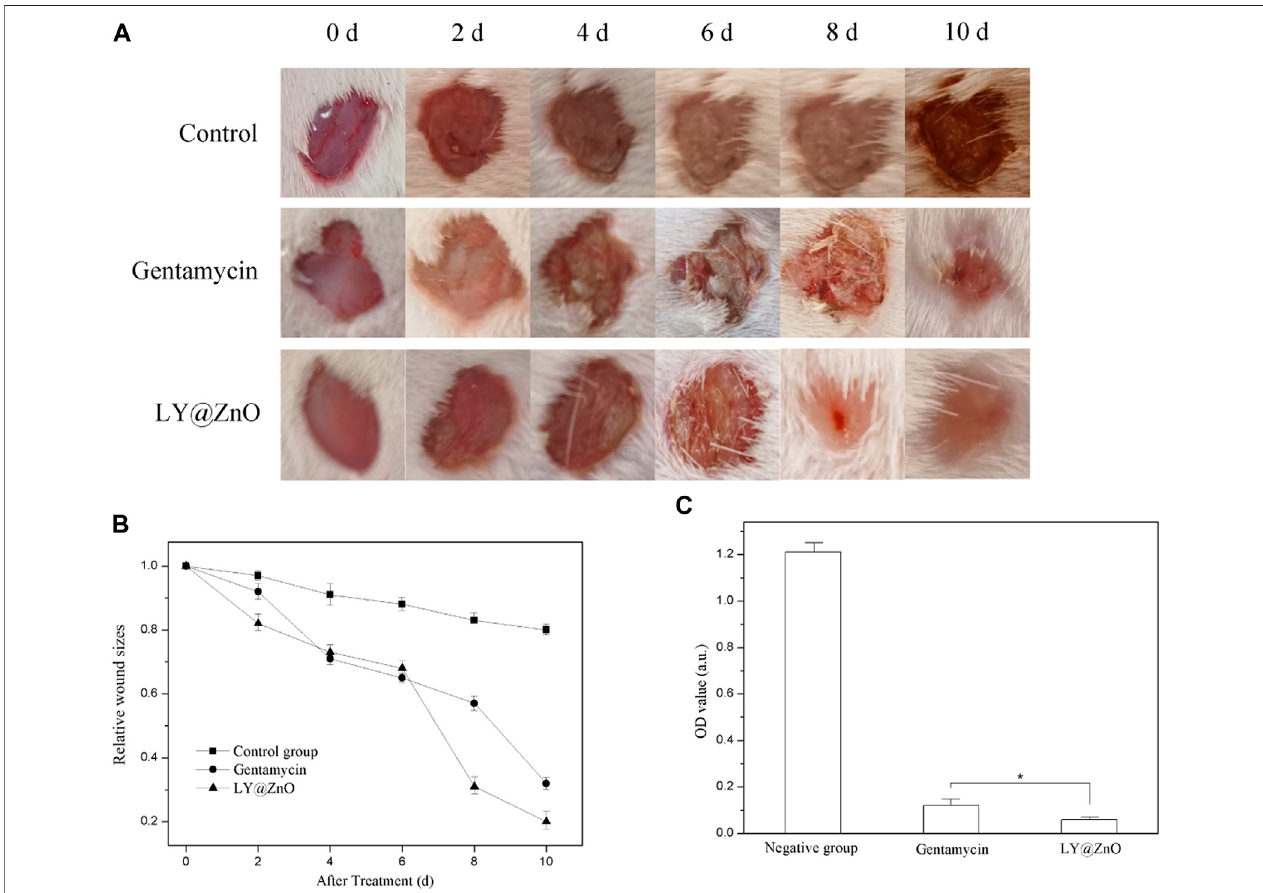
FIGURE 16 | (A) Images of wounds with sanitary saline, gentamycin, and LY@ZnO injected at different time points, (B) the size of wounds at different time points, (C) the OD value of bacteria obtained from the wound after 2 h cultured.